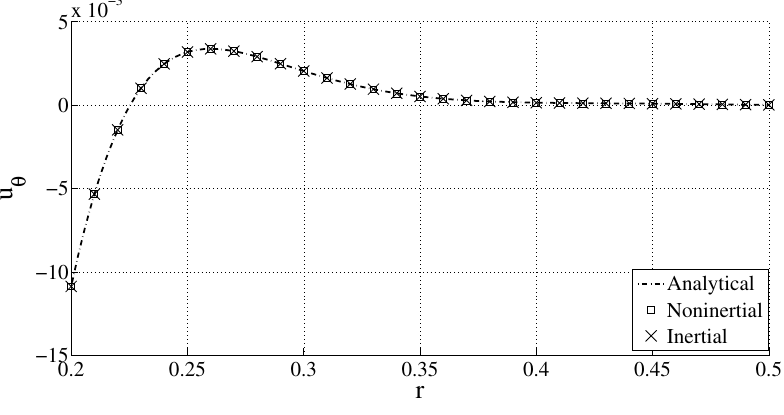
Figure 1. Comparison of the analytical and numerical solutions in the inertial and noninertial frames of